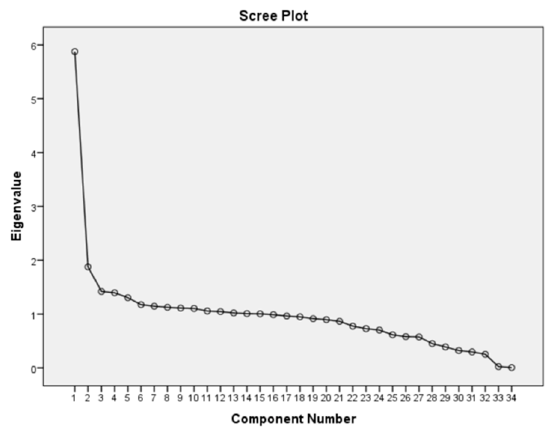
Figure 4. Scree Plot of Angola DHS data.